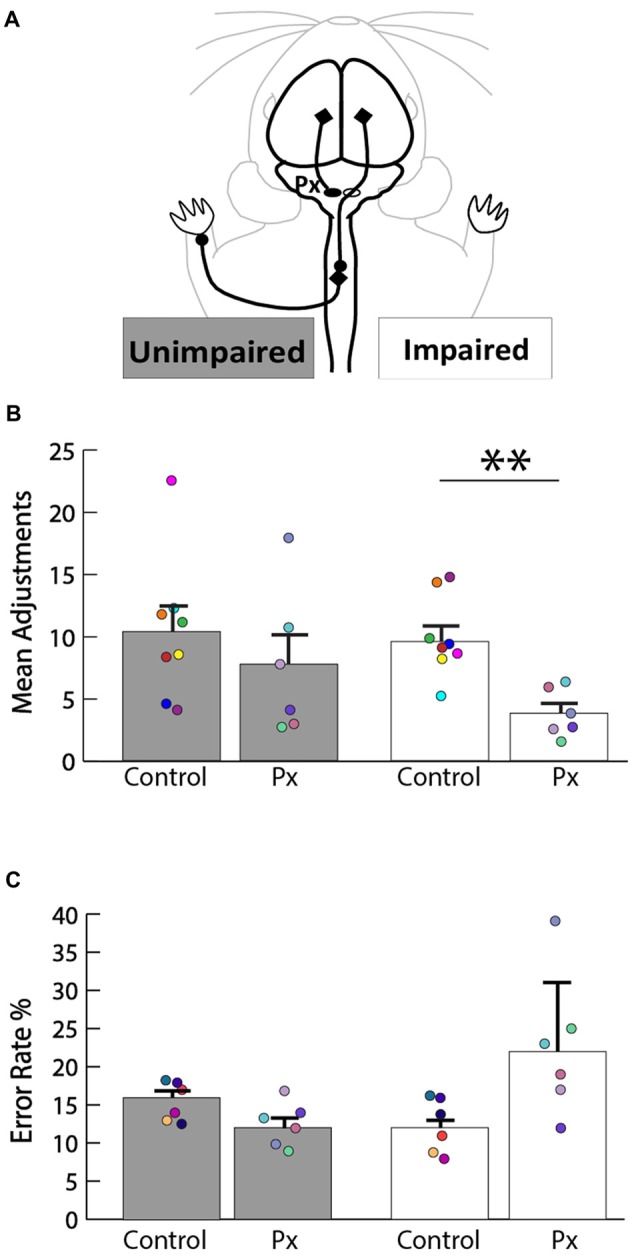
Motor deficits in rats with neonatal pyramidotomy. (A) Schematic of the intact CST that contributes to function of the unimpaired (left forepaw) and the impaired (right forepaw) forelimbs. (B) Pasta manipulation. The rats with neonatal pyramidotomy (Px) made fewer adjustments with their right forepaw than the control rats. No significant differences were detected in the amount of adjustments made by the left forepaw between the control and the Px rats. (C) Ladder walking. The right forepaw of the Px rats had a greater error rate percentage compared to that of the controls; however, left forepaw placement error was similar in the control and the Px rats. In addition, there were greater errors made with the right forepaw than the left forepaw in the Px rats. Data = mean ± SEM. Plotted dots represent each rat’s behavioral data points in each group. Each rat’s data are identified by the color of the dot. **p < 0.01.